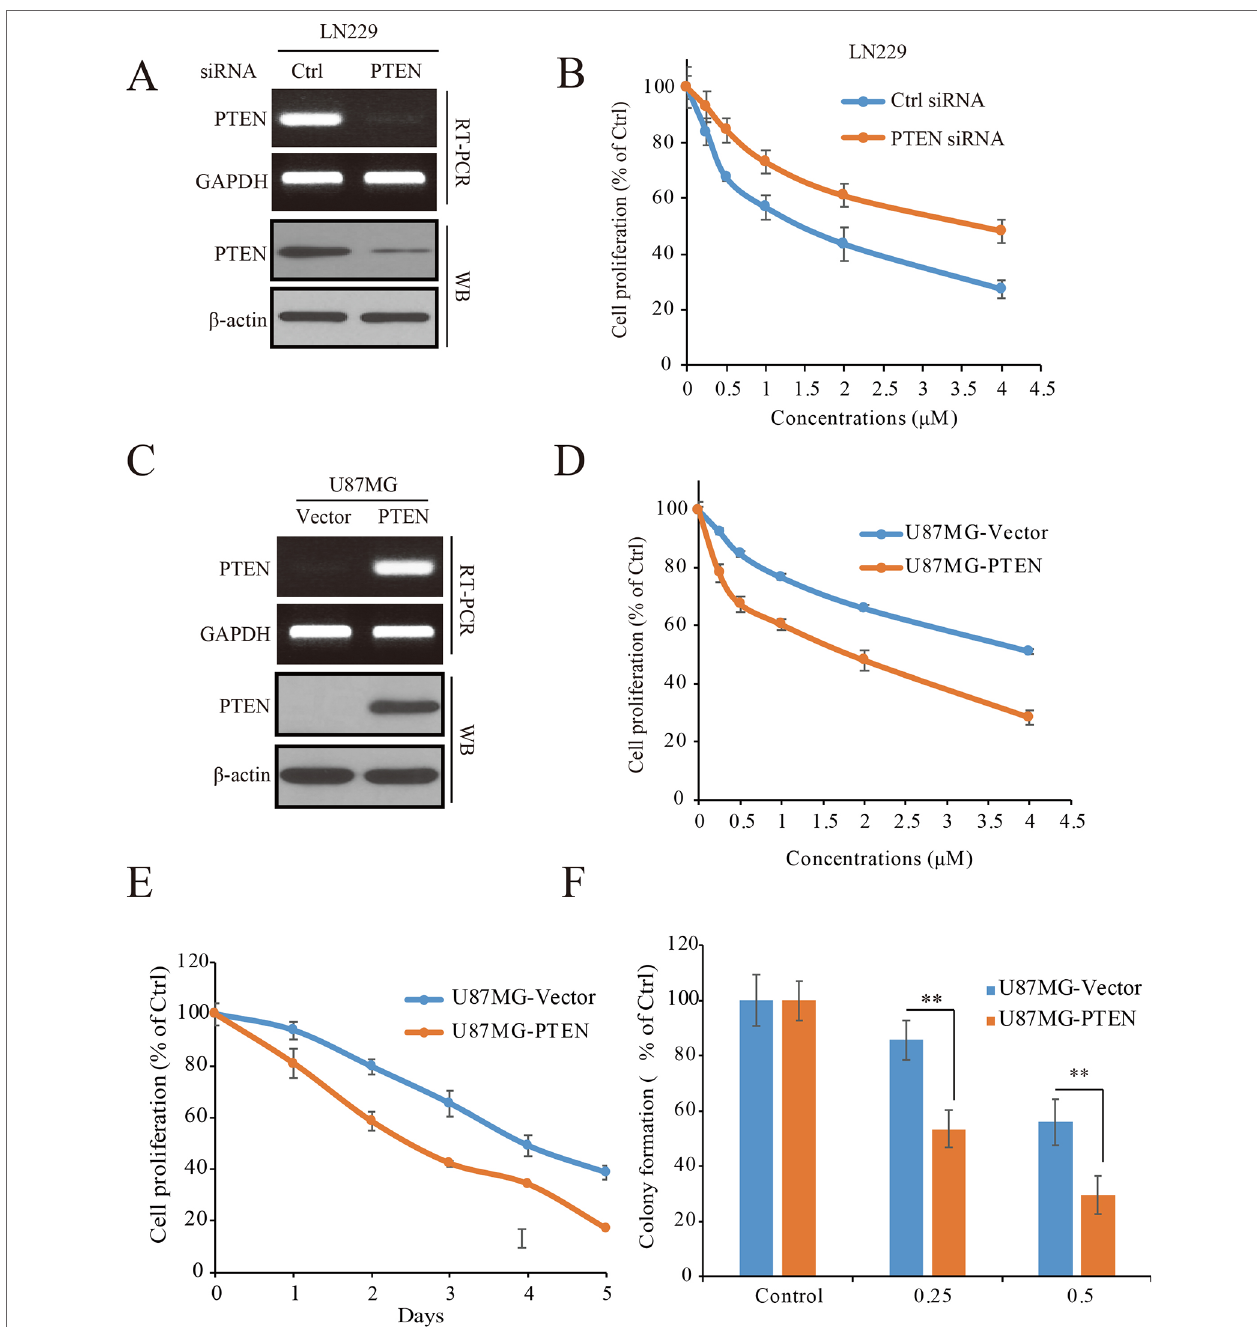
FIGURE 3 | PTEN enhances the sensitivity of GBM cells to palbociclib. (a) Detection of PTEN expression at mRNA and protein levels in cells transfected with PTEN/ control siRNA. Cell lysates/total RNA were collected and analyzed by western blot/RT-PCR assay as described in Materials and Methods . (B) PTEN knocking-down decreased the sensitivity of LN229 cells to palbociclib. Following PTEN/control siRNA transfection, cells were treated with palbociclib at indicated concentrations for 48 h. Cell proliferation was examined by MTT assay. Data are expressed as mean ± SD. (C) Detection of PTEN expression at mRNA and protein levels in isogenic U87MG cells. Cell lysates/total RNA were collected and examined by western blot/RT-PCR assay. (D) Expression of PTEN enhanced the efficacy of palbociclib against U87MG cells. Isogenic U87MG cells with or without PTEN were treated with palbociclib at indicated concentrations for 48 h, cell proliferation was assessed by MTT assay. Data are expressed as mean ± SD. (F) Time-course evaluation of palbociclib on isogenic U87MG cells. (E) Effects of palbociclib on colony formation of U87MG isogenic cells with different PTEN status. Data are shown as means ± SD (* P 0.05, ** P 0.01, t -test, n = 3).